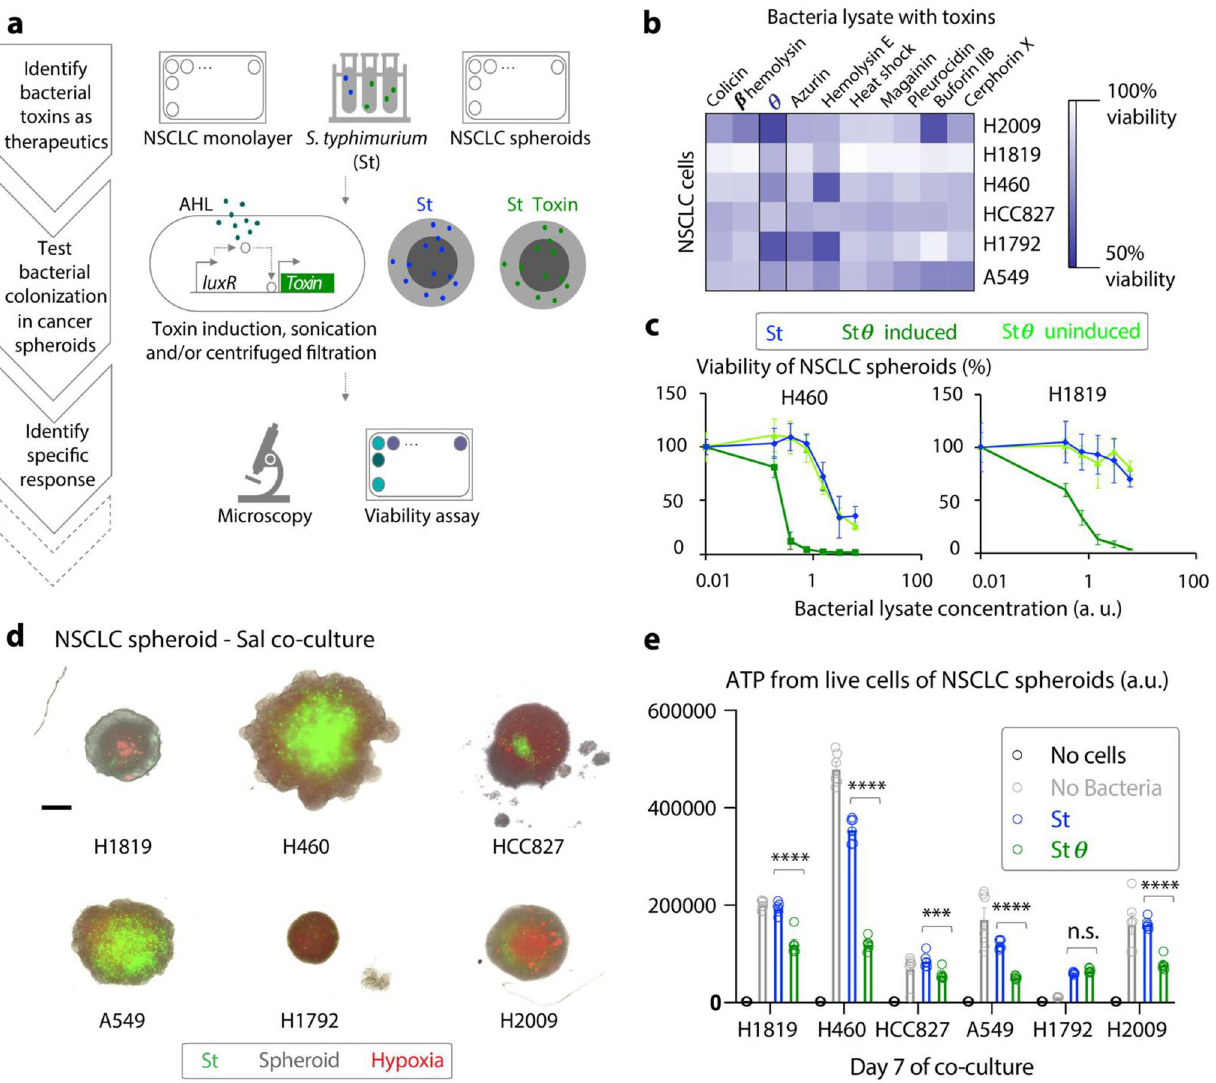
Figure 1. Identifying effective bacterial toxins for non-small cell lung cancer (NSCLC) therapy. ( a ) Schematic of the pipeline to identify bacterial toxins with potential as cancer therapeutics involving response of non- small cell lung cancer (NSCLC) to bacterial toxins in vitro, colonization of bacteria in NSCLC spheroids. ( b ) 2D monolayer screen using MTT viability assay to study the response of 6 NSCLC lines to 10 engineered bacterially secreted toxins. Fresh lysates of engineered S. typhimurium EHL1301 were prepared and were normalized for optical density before adding to the NSCLC cultures grown in 96-well flat bottom plates. The heatmap represents the median of percent viability (n = 8). ( c ) Viability of 2 NSCLC spheroids under 3 treatment conditions—serially concentrated lysate of S. typhimurium producing: (1) GFP and θ toxin (in presence of AHL) abbr. “Stθ induced”, (2) GFP and low amount of θ toxin due to leaky LuxR promoter (in absence of AHL) abbr. “Stθ uninduced”, and, (3) GFP only (n = 4) abbr. “St”, assessed by Cell Titer Glo 3D. Error bars represent standard deviation (n = 4). ( d ) Representative fluorescence microscopy images of 4-day old co-culture of 6 NSCLC spheroids (grey) with S. typhimurium producing GFP (green) and stained with hypoxia dye (red). Scale bar = 200 μM. ( e ) Viability of NSCLC- Salmonella co-culture spheroids using Cell Titer Glo 3D assay at day 7 (n = 6). Live S. typhimurium expressing θ toxin (Stθ) upon induction with AHL is abbreviated as “Stθ.” Significant change (**** = p < 0.0001, *** = p < 0.001, ** = p < 0.01, * = p < 0.5, n.s. = not significant) was determined by paired, two-tail t test, and error bars represent standard EHL1301 11,12 . We induced therapeutic production in S. typhymurium and applied bacterial lysates to cells, which identified θ toxin as having the highest effect on viability among all bacterial toxins tested (Fig. 1b, Supplementary Fig. 1). θ toxin is a pore forming toxin from C. perfringens 13 and was previously shown to have efficacy against murine colon cancer cells 11 . To model more physiologic conditions that occur within tumors containing poorly vascularized hypoxic regions where therapeutic efficacy is thought to be reduced 14 , we tested the effect of θ toxin on spheroids derived from a subset of our cell lines. We found that lysate of S. typhymurium expressing θ toxin